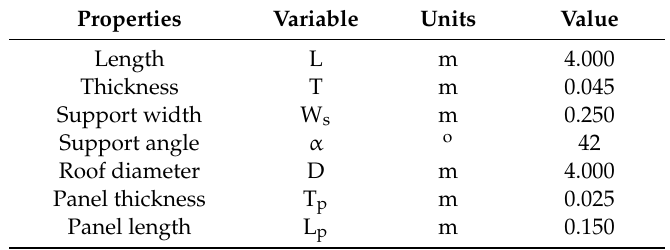
Figure 3. FDM process configuration for test specimen and the structural element manufacturing. Table 1. Main geometrical parameters of the plastic structural element.